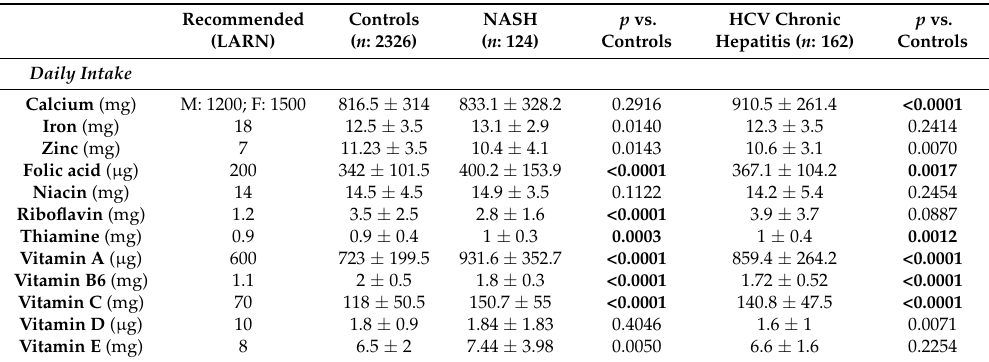
Table 3. Intake of micronutrients in study population (Mean ±